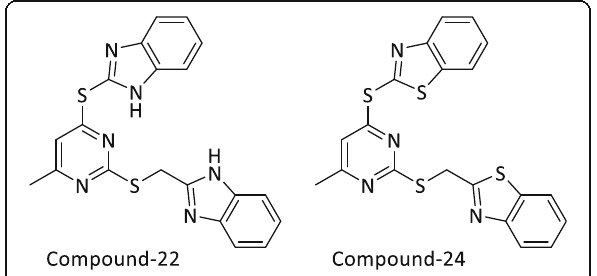
Fig. 34 Pyrimidine-benzoxazole/benzothiazole/benzimidazole compounds